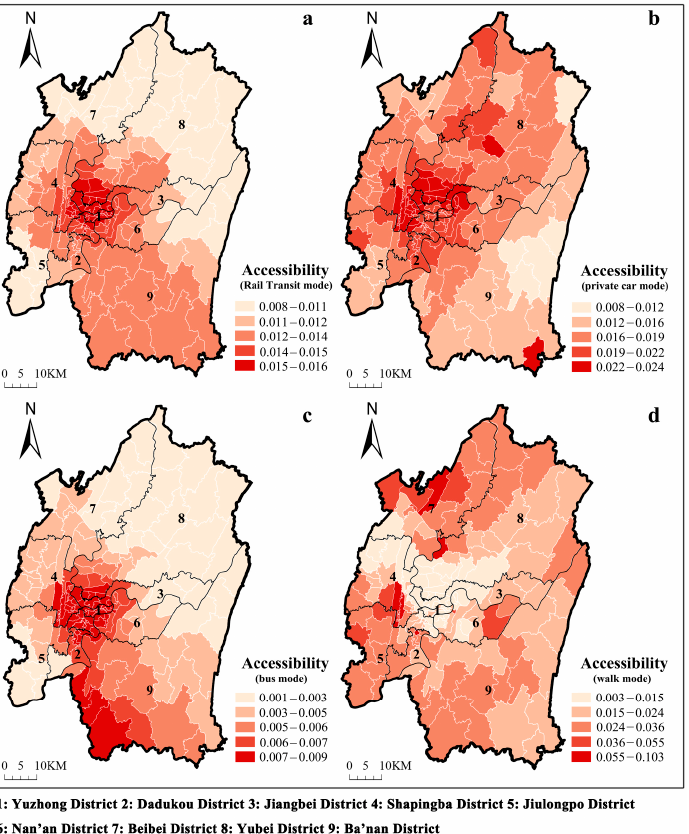
Figure 4. Spatial accessibility to ECFs under rail transit mode ( a ), private car mode ( b ), bus mode ( c ) and walk mode ( d ).